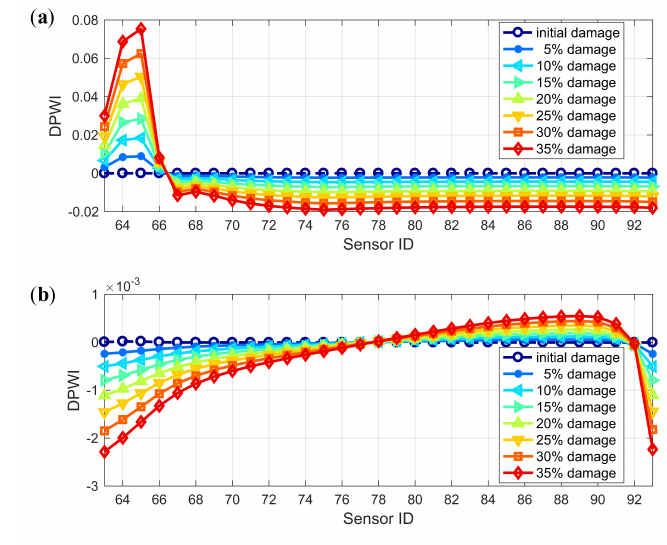
Figure 10. Damage identification results using DPWI : ( a ) Damage I; ( b ) Damage II.